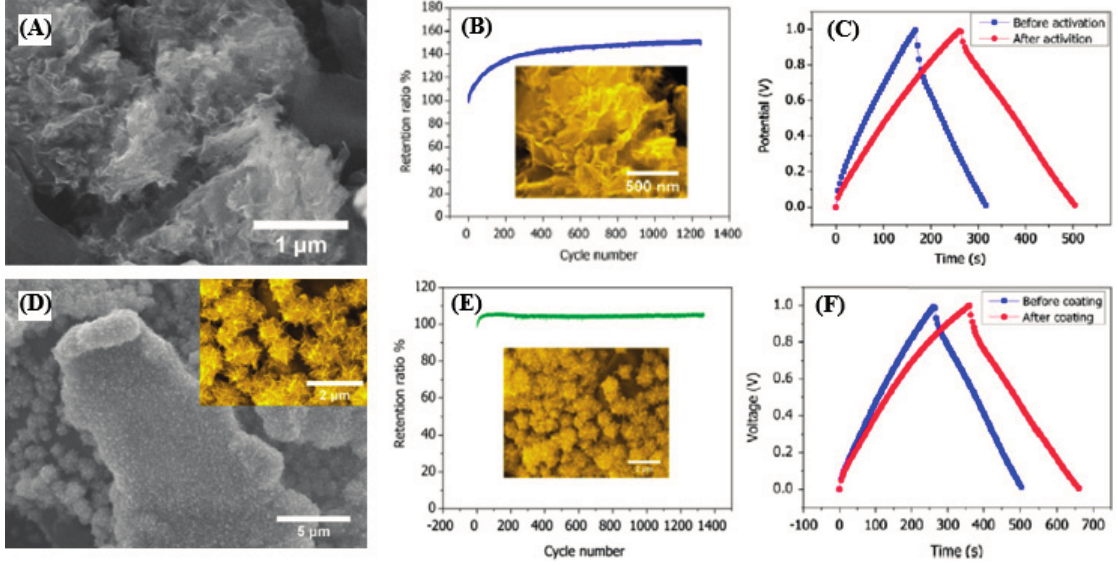
Figure 4. ( A ) SEM image of grapheme. ( B ) Electro-activation of graphene